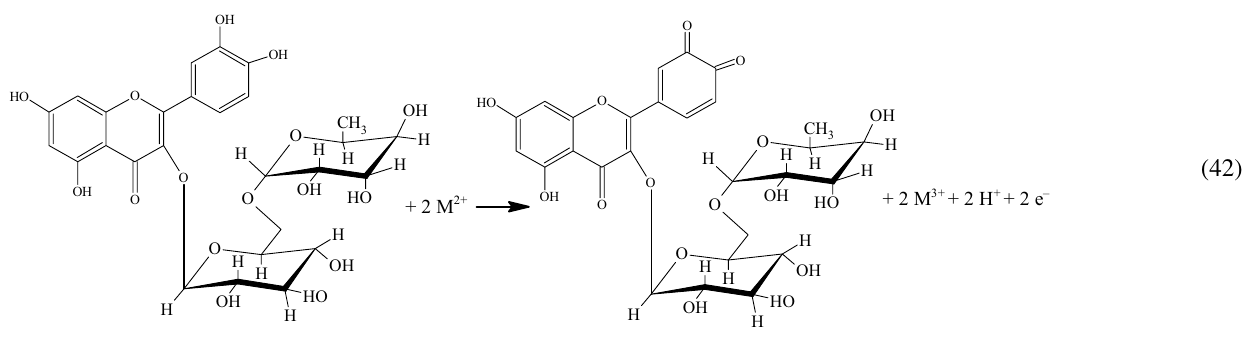
a Units in mg mL −1